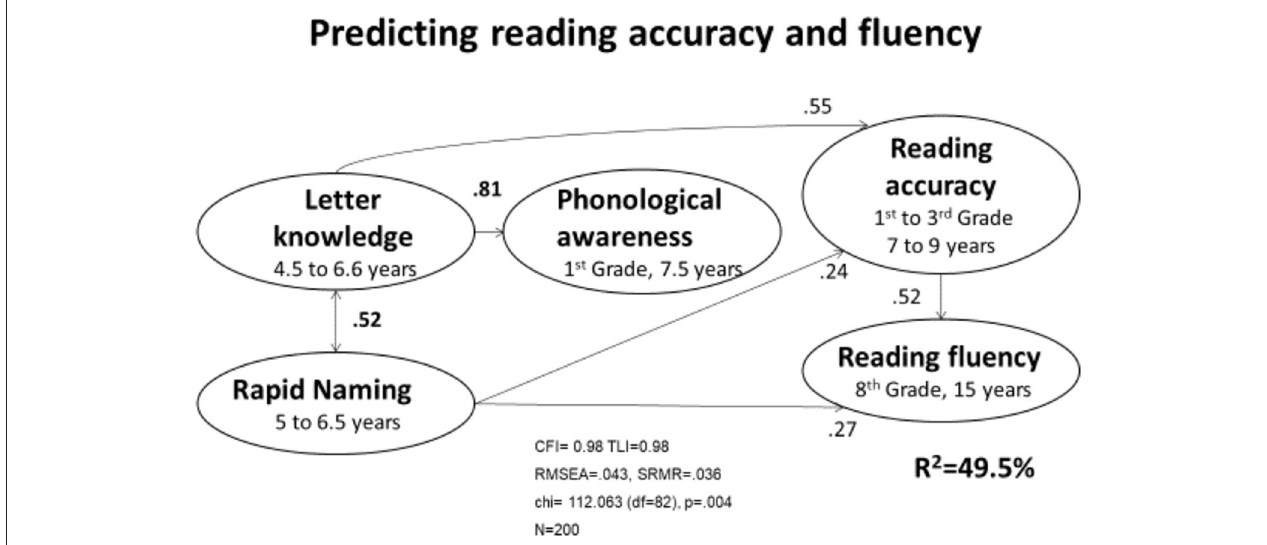
FIGURE 1 | Predicting reading accuracy and